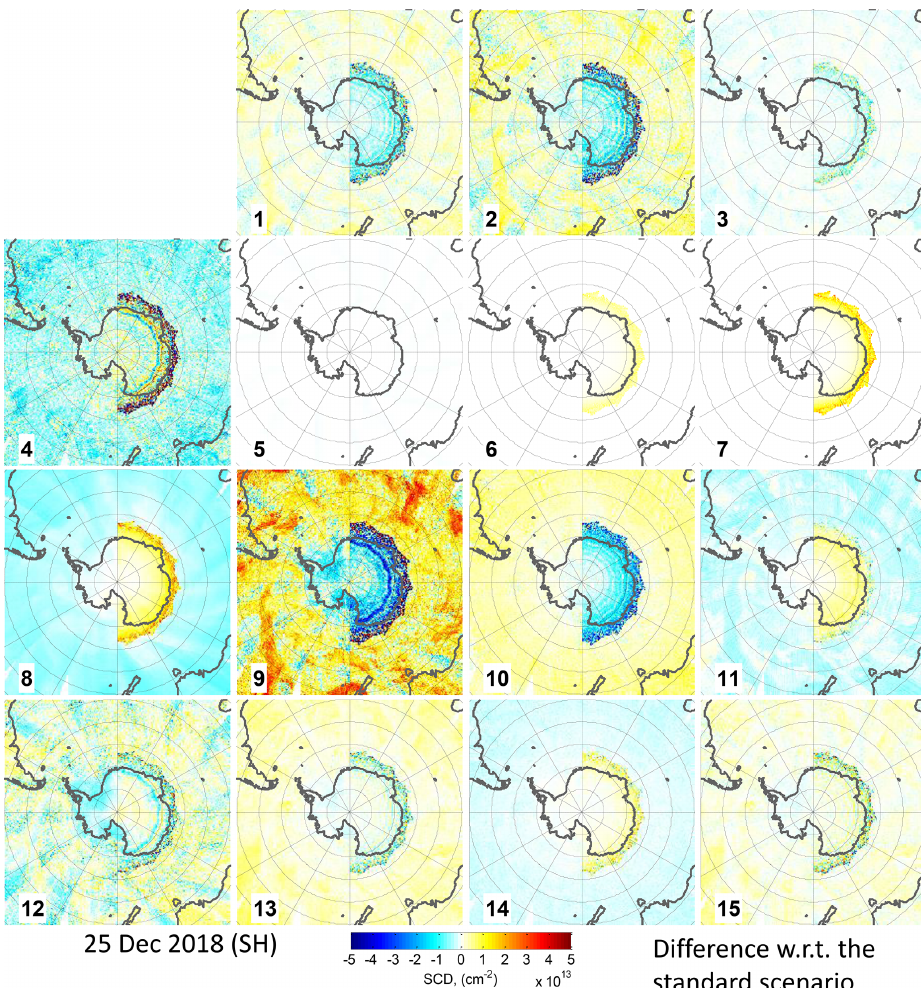
Figure B7. Same as Fig. B5 but for 25 December 2018 in the